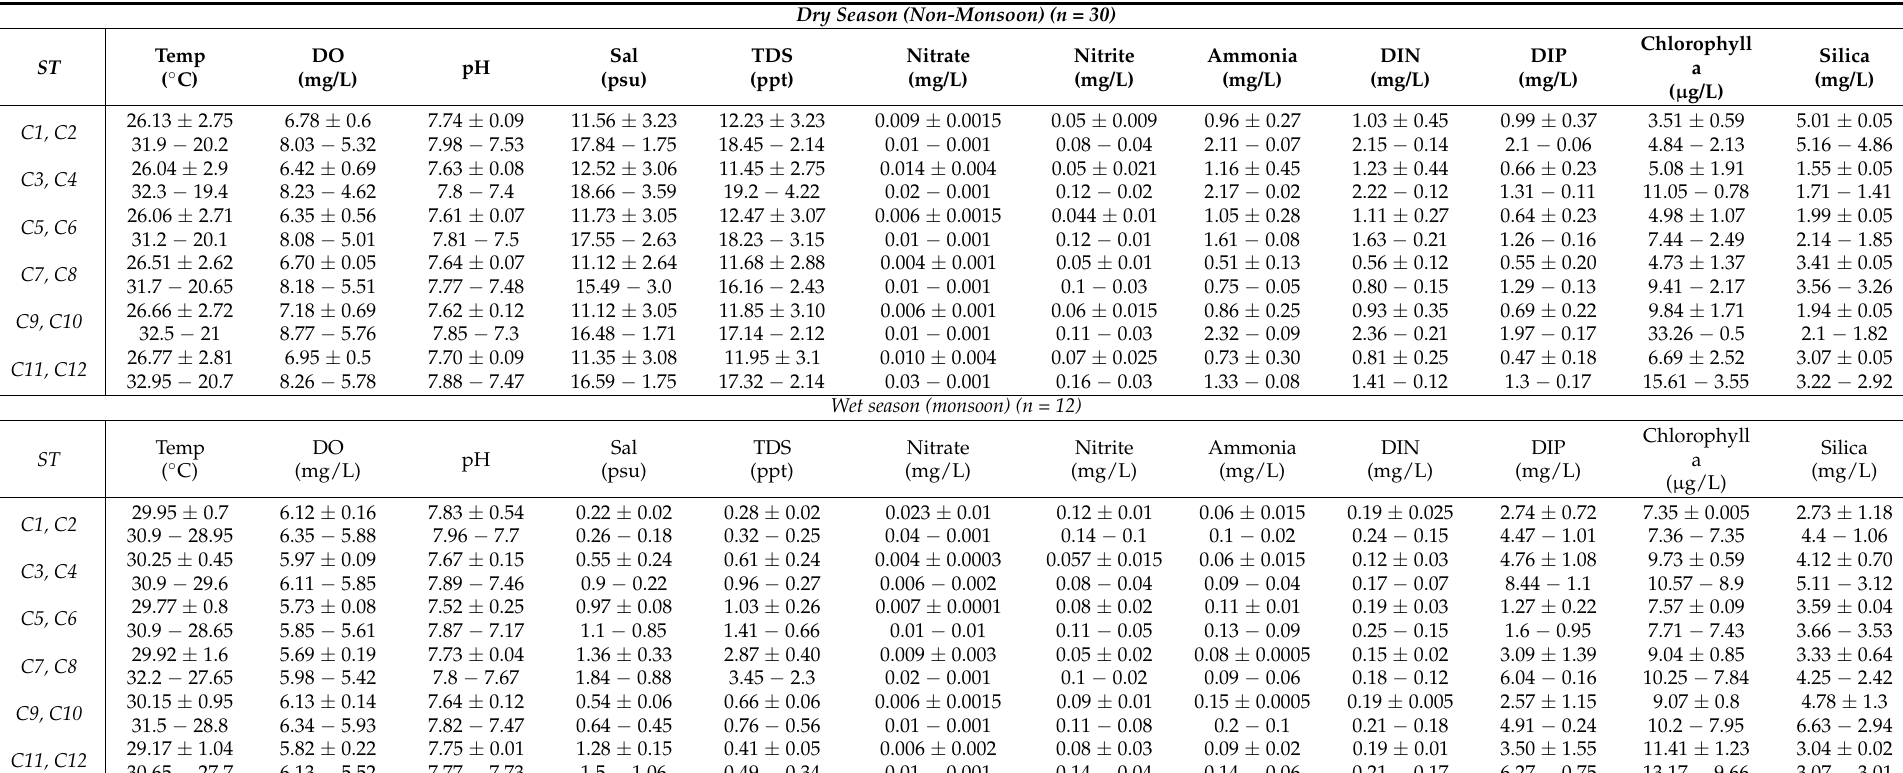
Table 3. Average, standard error, maximum, and minimum values of different environmental and chlorophyll a parameter distribution in the tidal mangrove